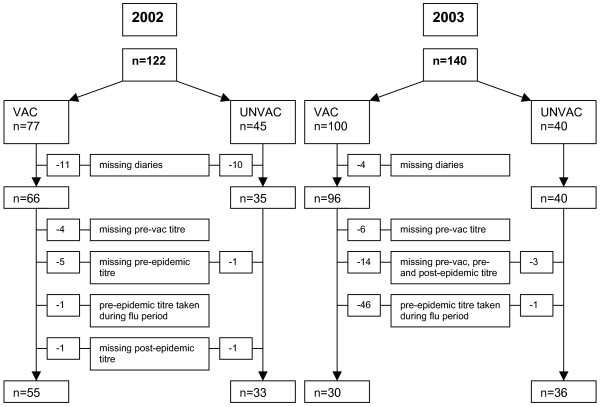
Flowchart of GPs' missing diaries and serology data.